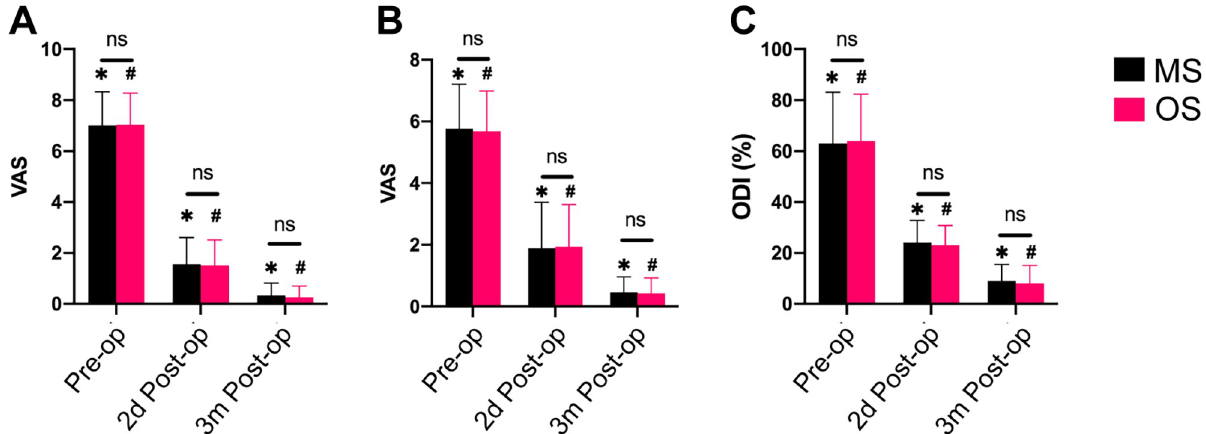
Fig 5. Clinical outcome. (A) VAS score of leg pain. (B) VAS score of low back pain. (C) ODI score. ns, no statistical difference; � P < 0.01 (significant difference among different time points of MS group); # P < 0.01 (significant difference among different time points of OS group).